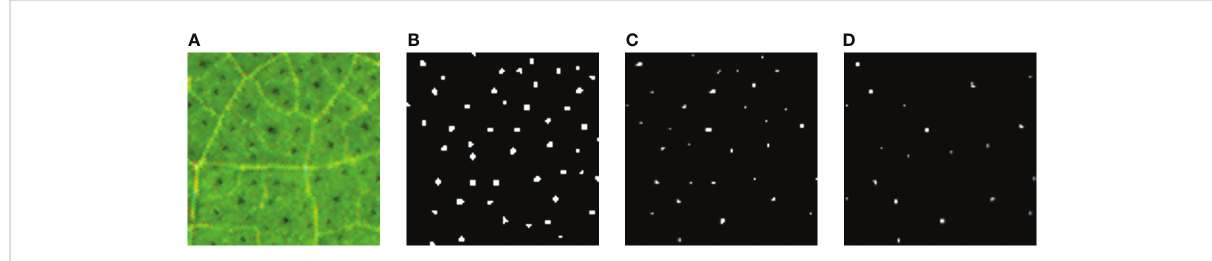
FIGURE 8 Comparison of segmentation results of the three models. (A) Original image; (B) The segmentation result of Ipp Net; (C) The segmentation result of U-Net; (D) The segmentation result of